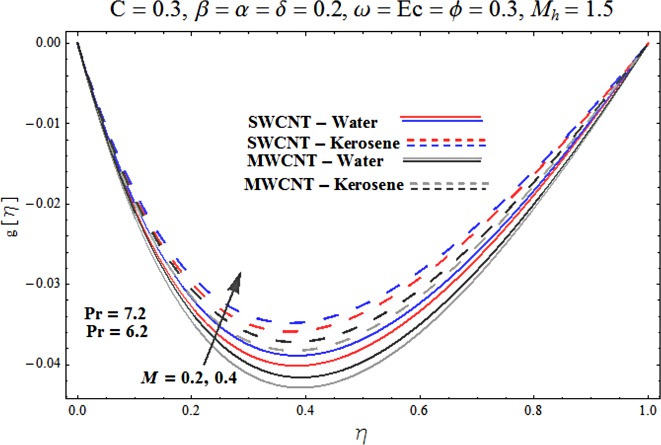
Effect of M on g′.